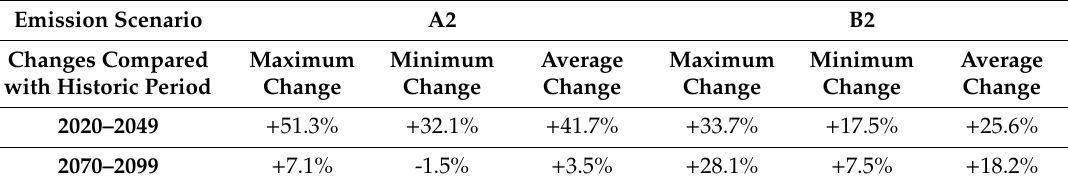
Figure 8. Monthly observed and simulated runoff under ( a ) A2 and ( b ) B2 scenarios in the near and far future. Table 3. Range of predicted changes in annual runoff over the historic period under A2 and B2 scenarios by the end of the century.